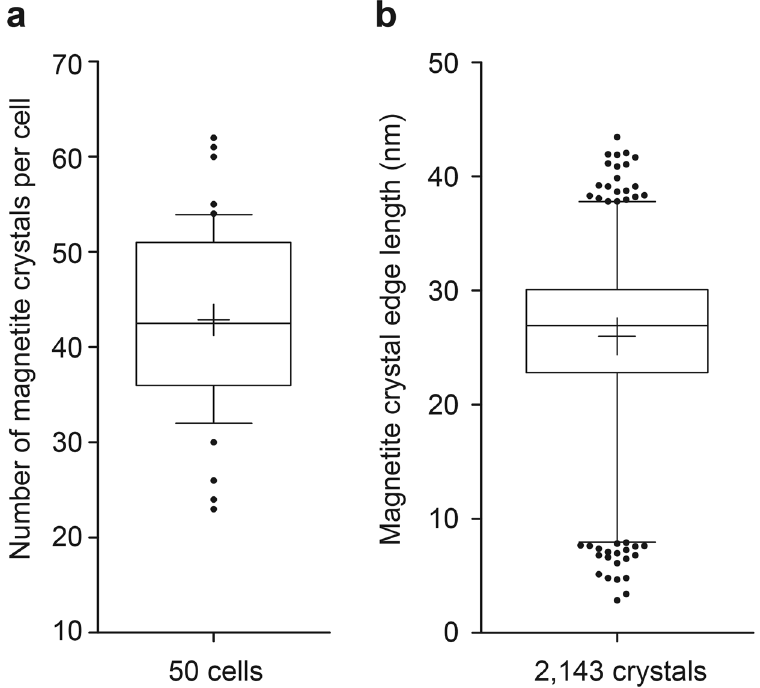
Figure 6. Distributions of the magnetite crystal numbers and sizes in M. gryphiswaldense cells. ( a ) Distribution of the number of magnetite crystals per cell. The data from 50 cells are represented in a box and whiskers plot. The box represents 50% of the central data, and the whiskers represent the 10–90 percentile. The central line depicts the median, and the cross indicates the average. ( b ) Distribution of the magnetite crystal edge length of 2,143 crystals from 50 cells. The box represents 50% of the central data and the whiskers show the 1–99 percentile. The central line depicts the median, and the cross indicates the